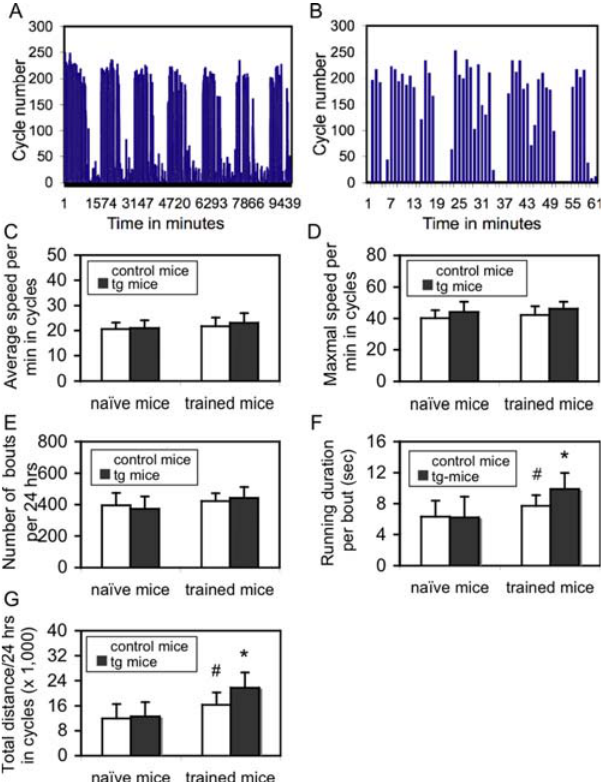
Figure 6. Effects of VMT on running behaviors. A. A typical circadian running behavior in a 1-week period from a tg mouse. Two circadian phases are clearly shown within every 24 hrs. Running phase was generally from 19:00 PM to 07:00 AM and non-running phase was from 07:00 AM to 19:00 PM. A low running activity was still observed in both control and tg mice during the non-running-phases. No any significant difference in this circadian pattern was found between control and tg mice. B. A typical running curve in a 1 hr-duration during a running phase from a tg mouse. C. Average running speed in cycles per minute. There was no significant difference between naı¨ve control and naı¨ve tg mice, between trained control and trained tg mice, and between trained and naı¨ve mice. D. Maximal running speed in cycles per minute. There is no significant difference between naı¨ve control and naı¨ve tg mice, between trained control and trained tg mice, and between trained and naı¨ve mice. E. Number of cycling bouts per 24 hrs. There was no significant difference between naı¨ve control and naı¨ve tg mice, between trained control and trained tg mice, and between trained and naı¨ve mice. F. Running duration per bout. There was no significant difference between naı¨ve control and naı¨ve tg mice. However, a significant prolonged duration was observed in trained control mice, when compared to naı¨ve control mice ( # , p , 0.05, Student’s t test), and in trained tg mice, when compared to